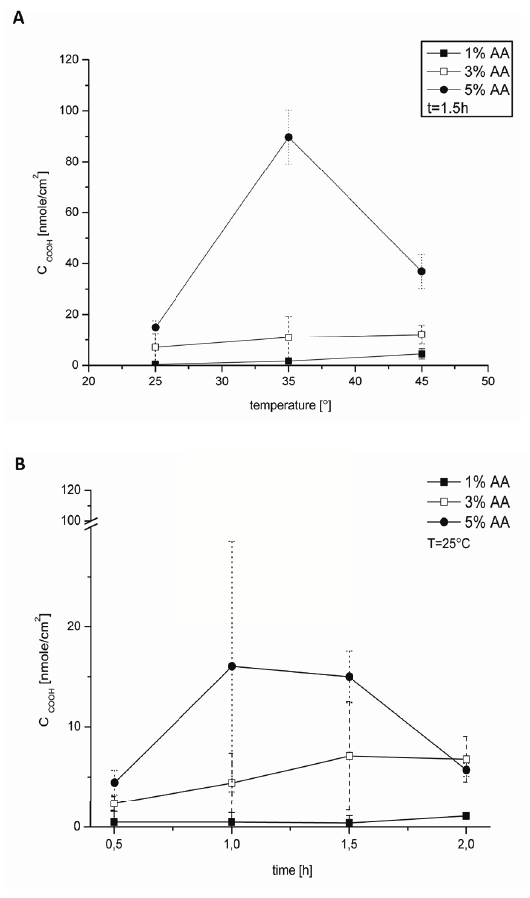
Figure 3: Concentration of COOH groups on the polyurethane (PU) surface aft er acrylic acid (AA) graft ing as a function of of a) temperature of graft ing reaction and b) time of graft ing .MV±SD,